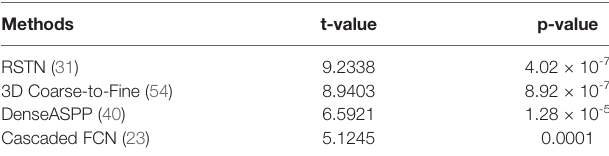
TABLE 3 | t-value and p-value for our method by one sample